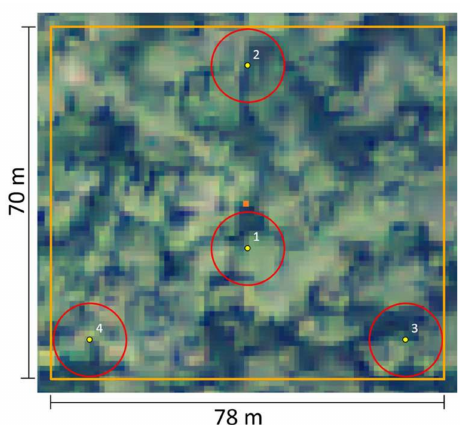
Figure 3. Extent (orange box), central pixel (solid orange square), and spatial layout of an Forest Inventory Analysis (FIA) plot (red circles) with National Agricultural Imagery Program (NAIP) imagery in the background.